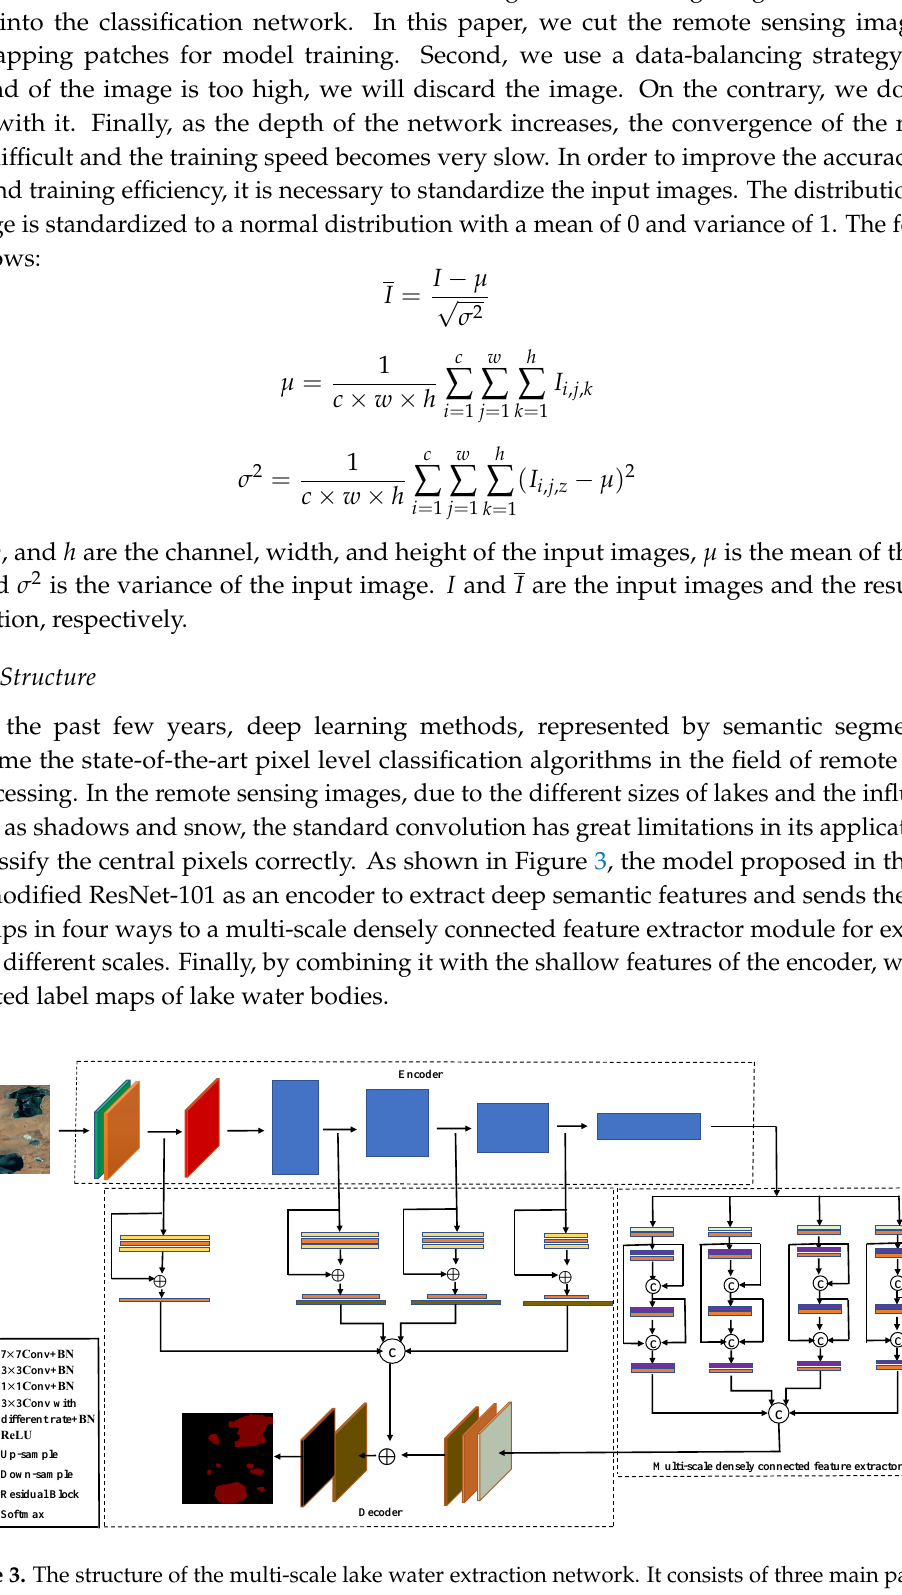
Figure 3. The structure of the multi-scale lake water extraction network. It consists of three main parts: an encoder, a multi-scale densely connected feature extractor, and a